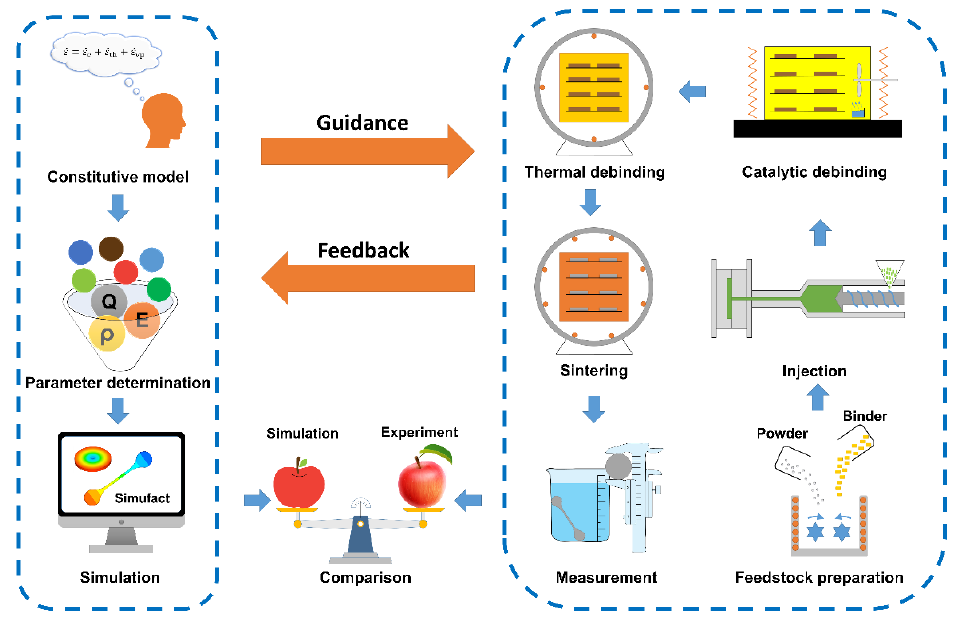
Figure 1. Schematic diagram of the workflow in this study.